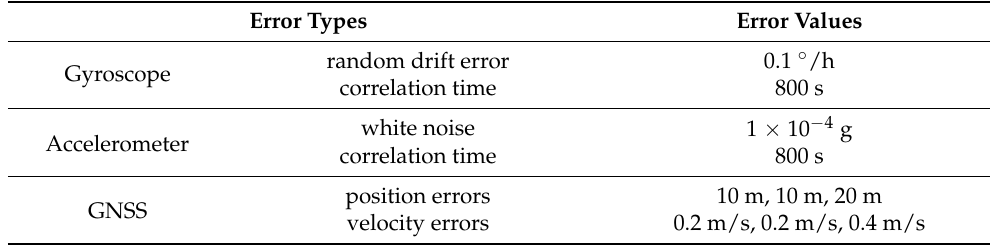
Table 2. Errors of different sensors.